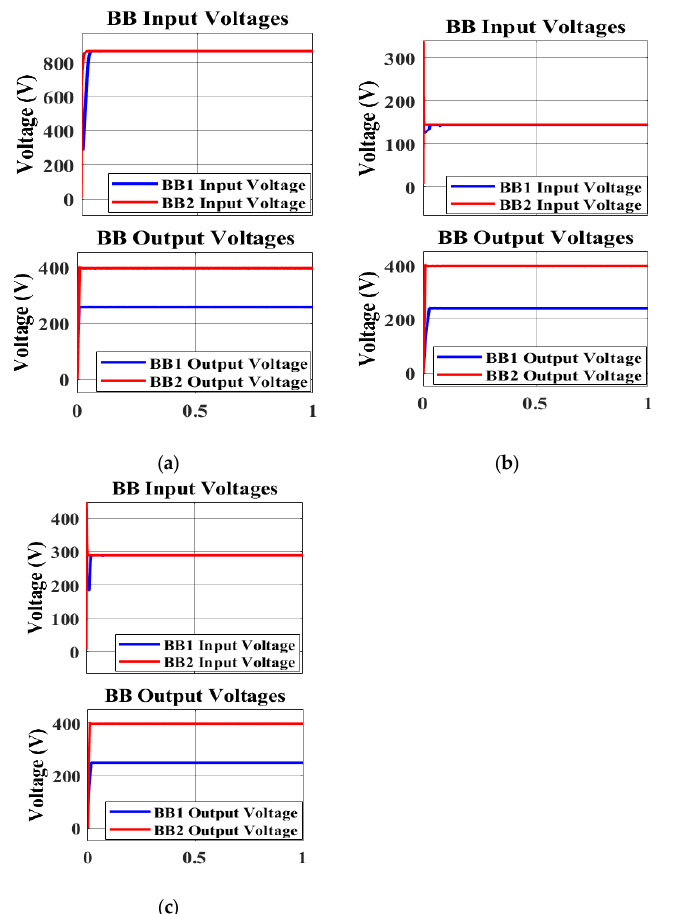
Figure 9. The input and output voltages of the BB converters’ operation: ( a ) buck converters, ( b ) boost converters, and ( c ) the first converter is buck and the second is boost.